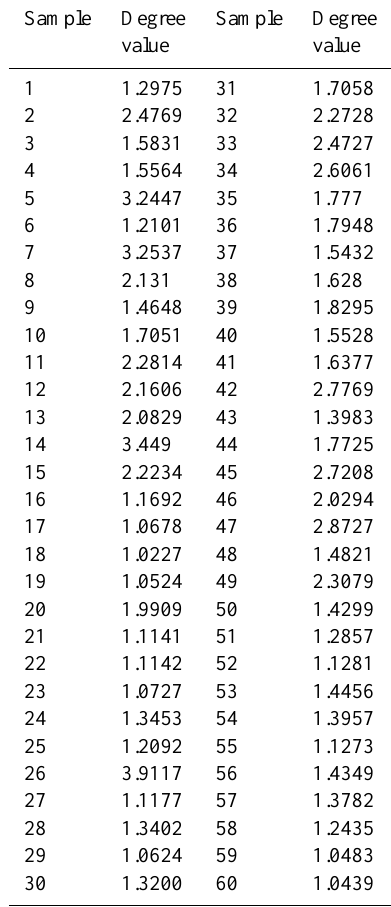
Table 3. Pairwise comparison of the alternatives with respect to flood disasters.